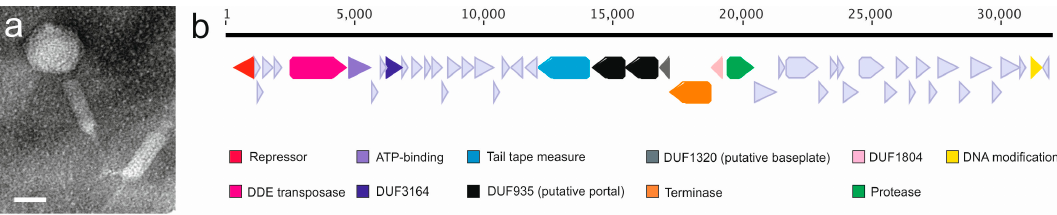
Figure 1. ( a ) Temperate phage fF4 of Flavobacterium columnare ATCC 23463 seen under a transmission electron microscope. Scale bar: 50 nm. ( b ) Genome organization of fF4 with predicted open reading frames (ORFs) and putative functions, when detected, indicated at the bottom.